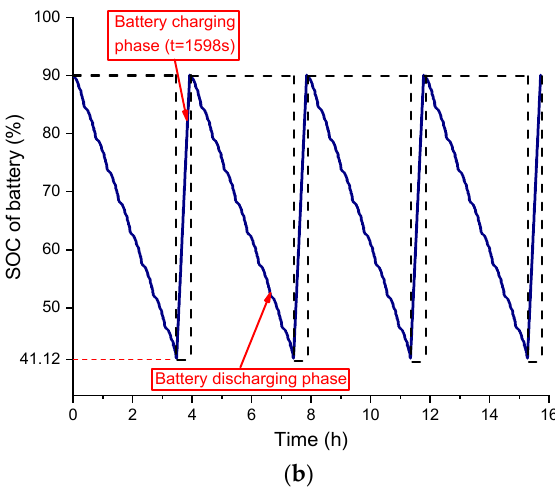
Figure 17. The battery SOC change based on different power distribution strategies in one day: ( a ) the battery SOC based on the optimization strategy described in this paper; and ( b ) the battery SOC based on the rules of the power distribution strategy.